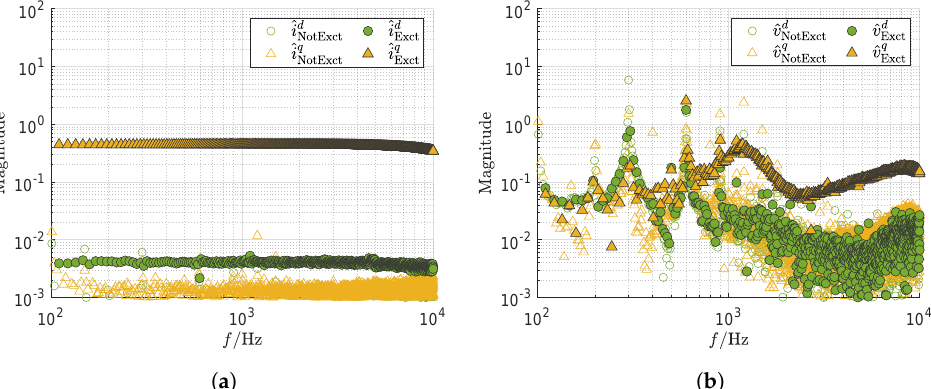
Figure 26. Measurement of the industrial power grid during excitation of the q -axis. ( a ) Spectrum of the current i meas in the dq domain. ( b ) Spectrum of the voltage v meas in the dq domain.